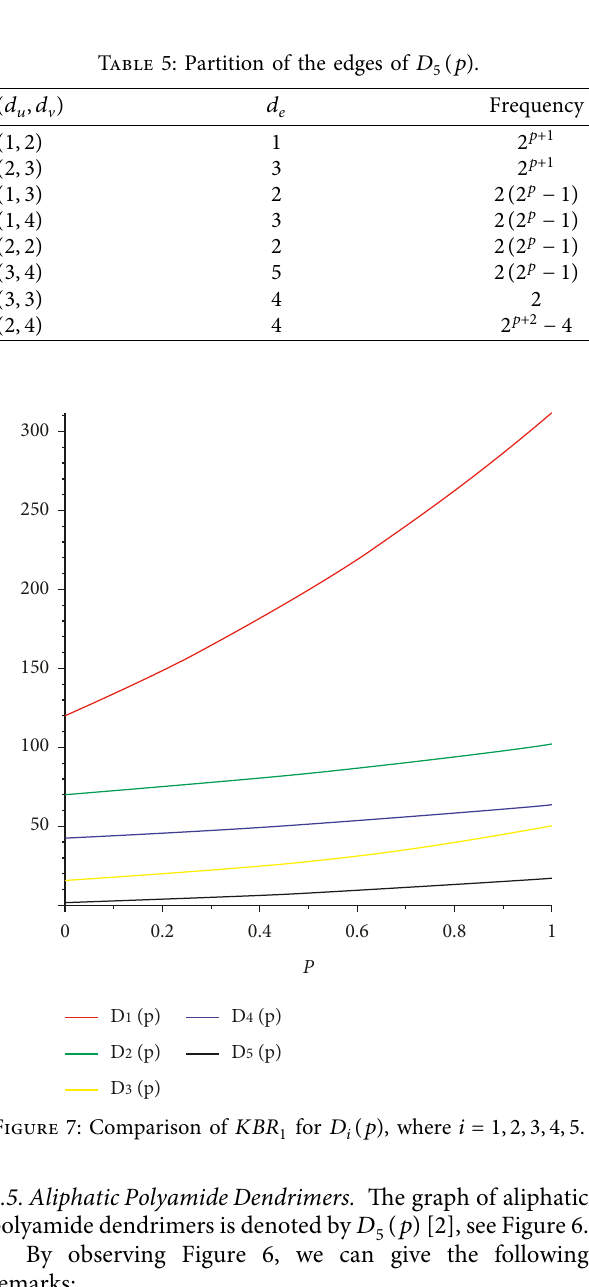
Table 4: Partition of the edges of D